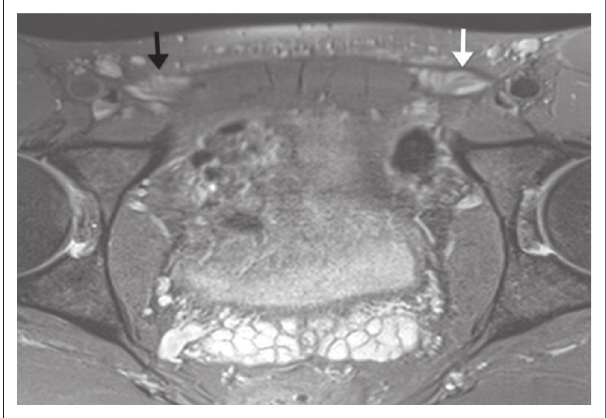
FIGURE 5: Spectrum of adductor dysfunction: (a) Adductor tendinosis. A 46-year-old professional tennis player with chronic groin pain on the right. Axial fat-saturated proton density (PD) image demonstrates a thickened adductor longus tendon of intermediate signal (white arrow) surrounded by fluid (white arrowhead) on the right. Note the normal adductor longus tendon on the left (black arrow); (b) Adductor strain in a 17-year-old soccer player with acute left groin pain. Axial fat-saturated PD image demonstrates fluid signal in relation to the adductor longus musculotendinous unit (white arrow); (c) Adductor aponeurotic tear in a 27-year-old rugby player with subacute left groin pain. Coronal fat-saturated PD image demonstrates adductor aponeurotic tear on the left (white arrow); (d) Common adductor-rectus abdominis tear in a 30-year-old professional rugby player with left groin pain of 3 weeks’ duration. Coronal fat-saturated T2 image demonstrates tear of adductor longus origin (white arrow). Note the metallic artifact from prior bilateral hernia surgery (black arrows); (e) Coronal fat-saturated T2 image (same patient/athlete as in Figure 5d) demonstrates associated partial tear of rectus abdominis (white arrow). This injury pattern highlights the prepubic aponeurotic complex (P-PAC) anatomic configuration.